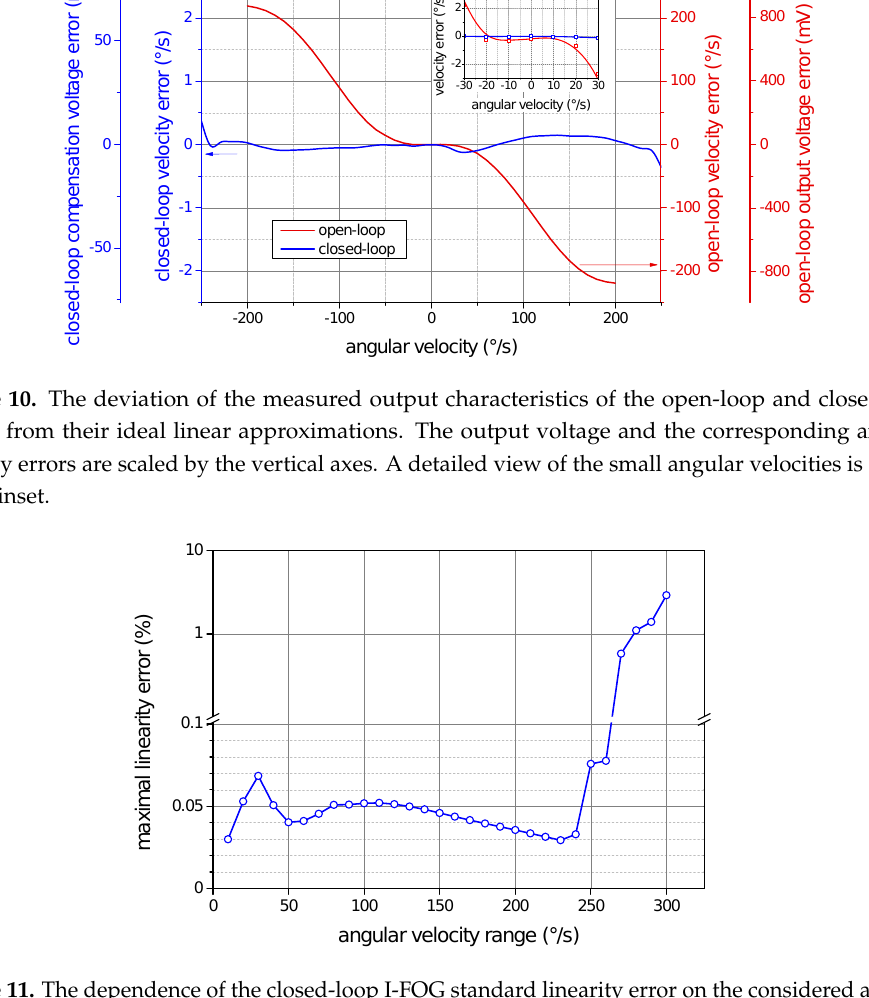
Figure 11. The dependence of the closed-loop I-FOG standard linearity error on the considered angular velocity